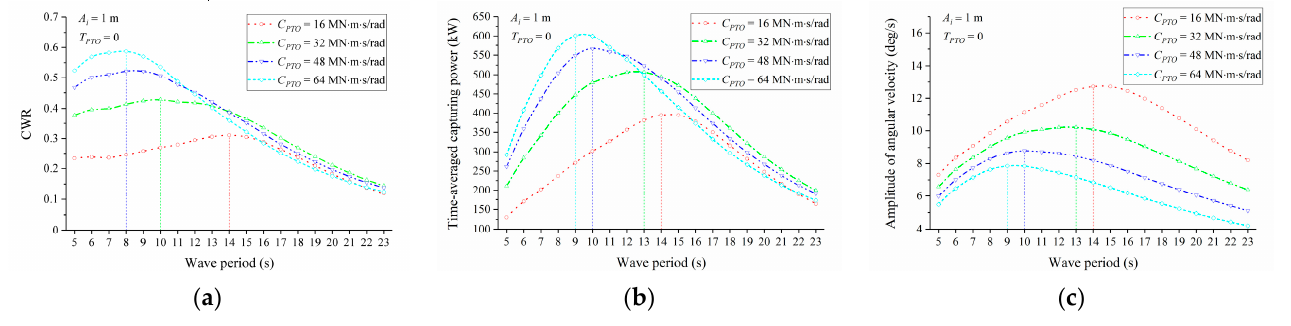
Figure 23. The results of a no-friction flap ( T PTO = 0) with various values of PTO damping C PTO under unit-amplitude regular waves: ( a ) CWR; ( b ) time–averaged capturing power; ( c ) angular velocity amplitude. Table 4. The periods of peak values of various items under unit-amplitude regular waves. The Periods of